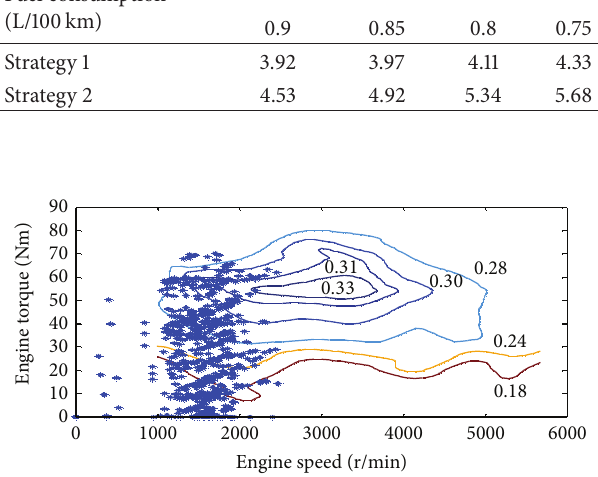
Figure 9: Engine operating points of strategy